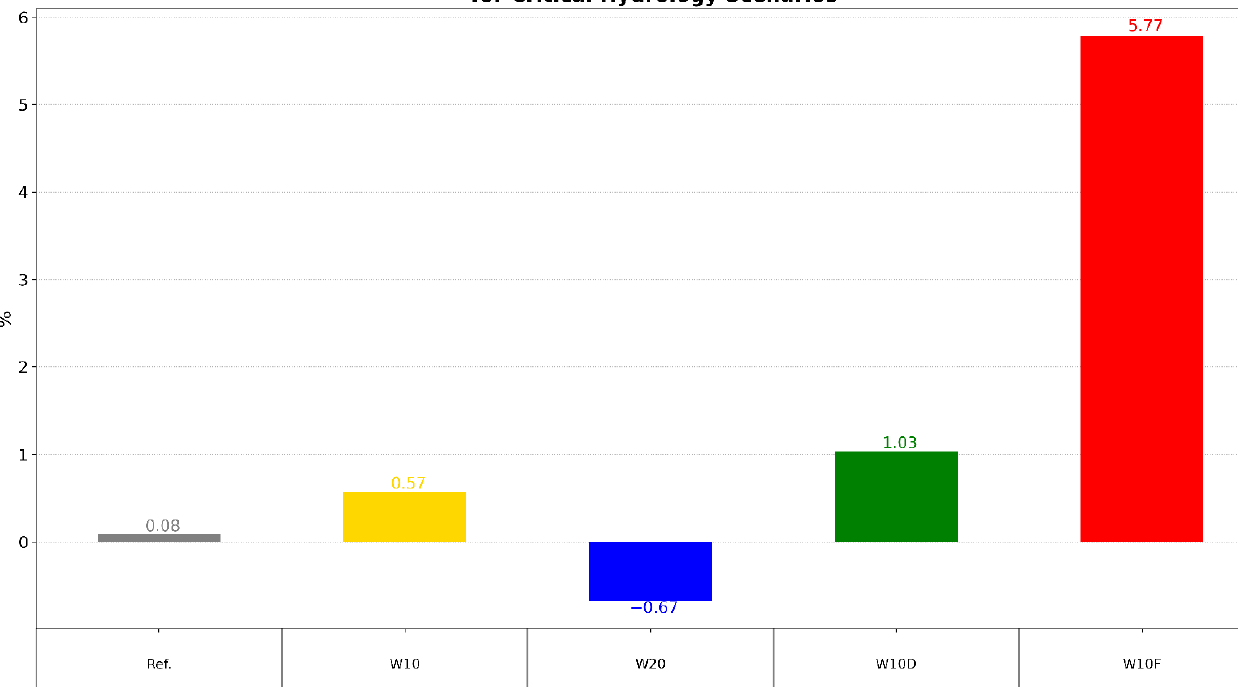
Figure 7. Percentage difference between flat and seasonal cases for total cost in the system for sce- narios with critical hydrology.